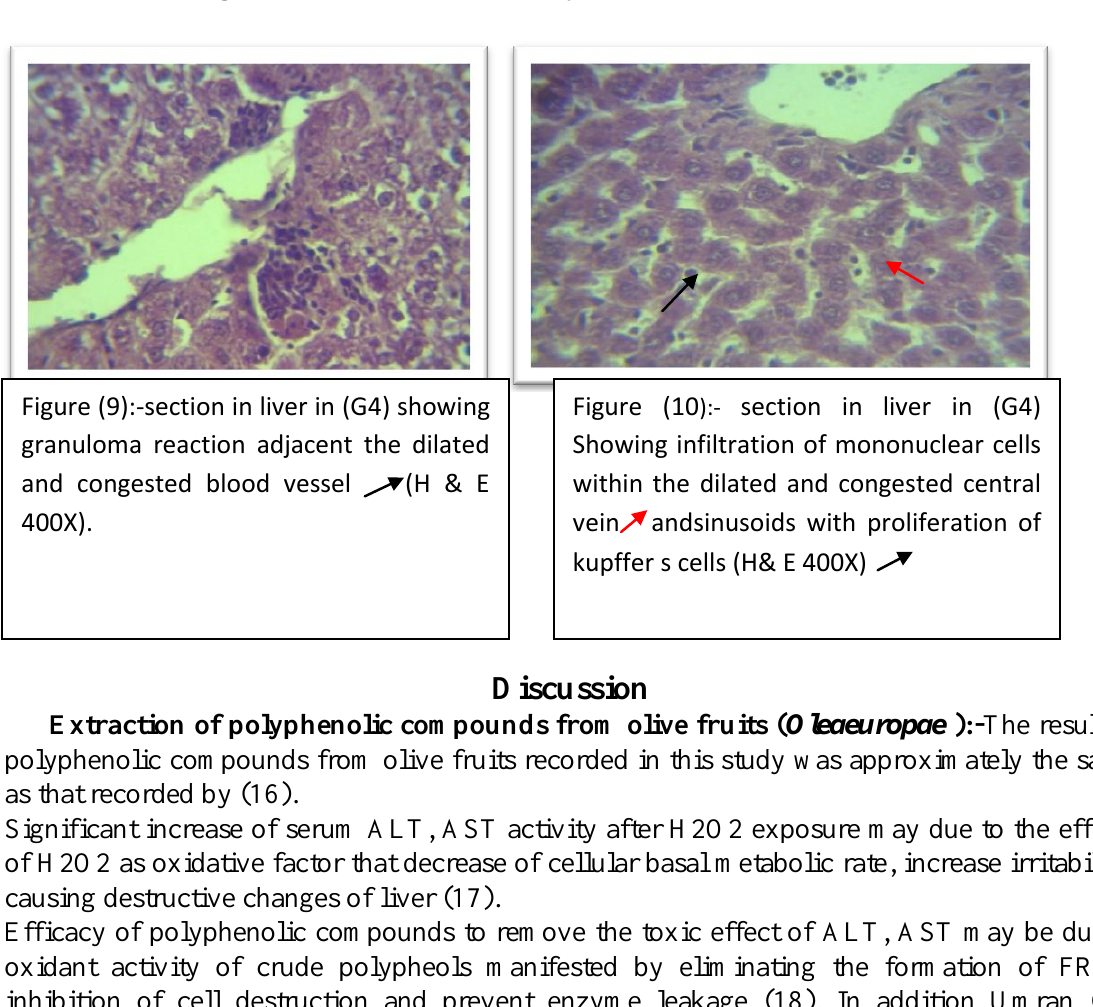
Figure (9):-section in liver in (G4) showing granuloma reaction adjacent the dilated and congested blood vessel (H & E 400X).